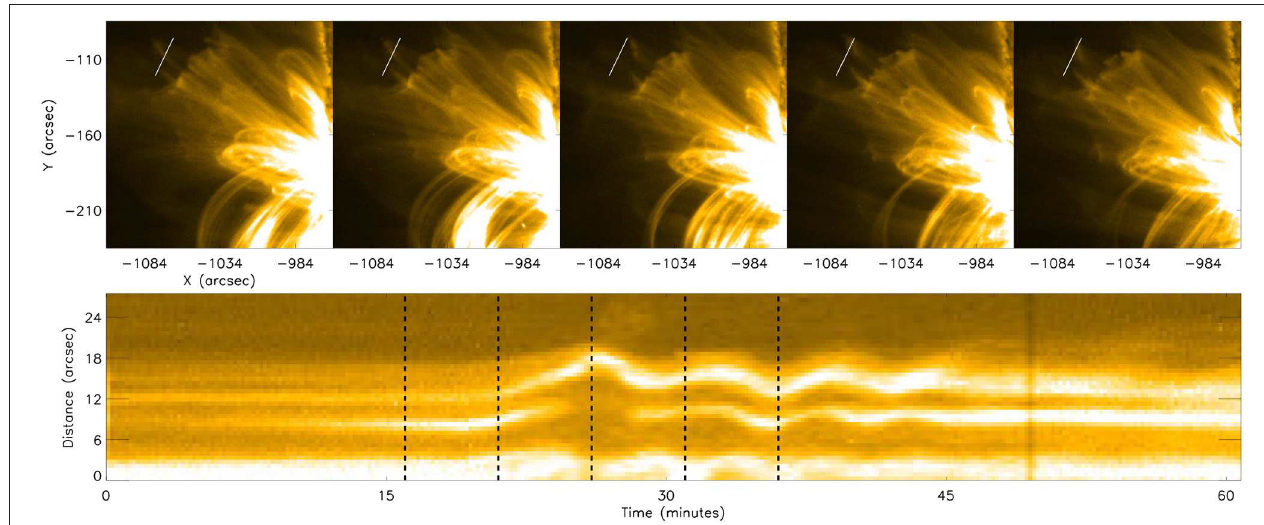
FIGURE 2 | (Top) The coronal loop system analyzed here plotted using 171 Å data at five times during the oscillation. The white lines indicate the slit studied in this article, which corresponds to Loop 40, Event 2 from Goddard et al. (2016). (Bottom) Time-space diagram constructed from the slit over-laid on the 171 Å data. The dashed vertical lines indicates the time steps plotted in the top row (from left to right). The bright chord starting and finishing at 12 ′′ is the oscillation studied in this